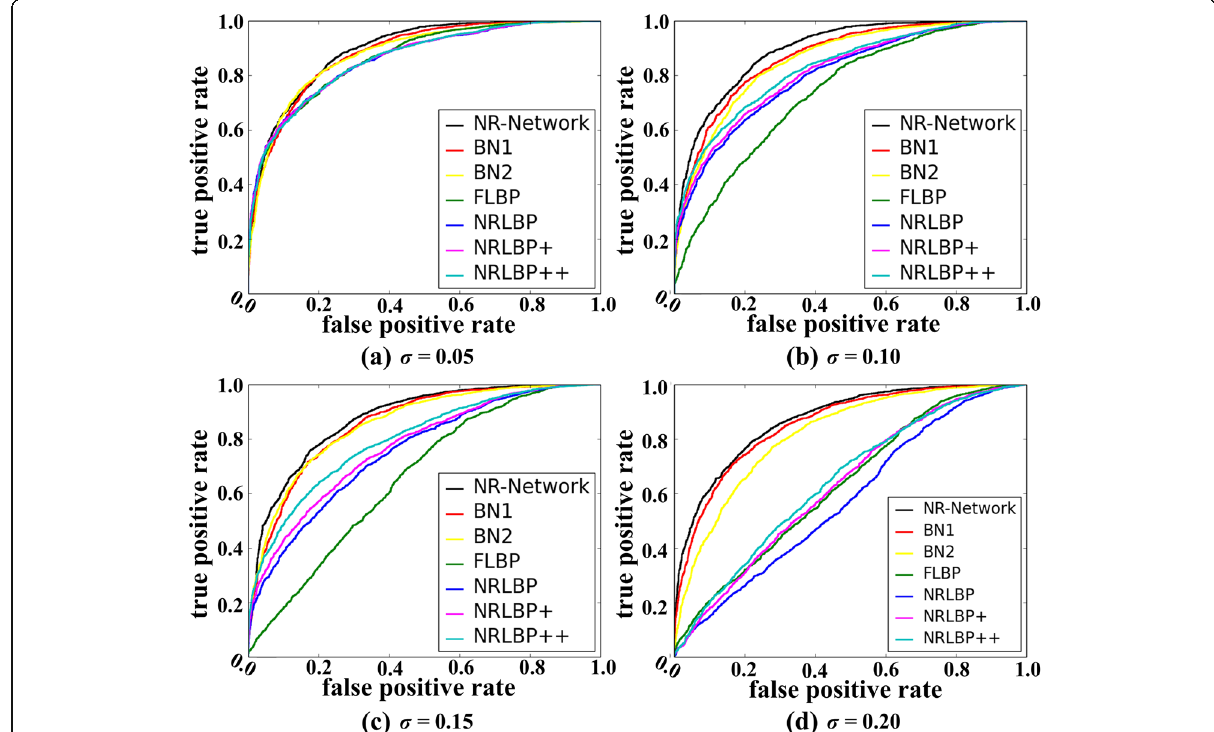
Fig. 5 The ROC curves on the AR database with Gaussian noise σ = 0.05, 0.10, 0.15, 0.20. Black line the NR-Network method, red line the BN1 method, yellow line the BN2 method, green line the FLBP method, blue line the NRLBP method, carmine line the NRLBP+ method, cyan line the NRLBP++